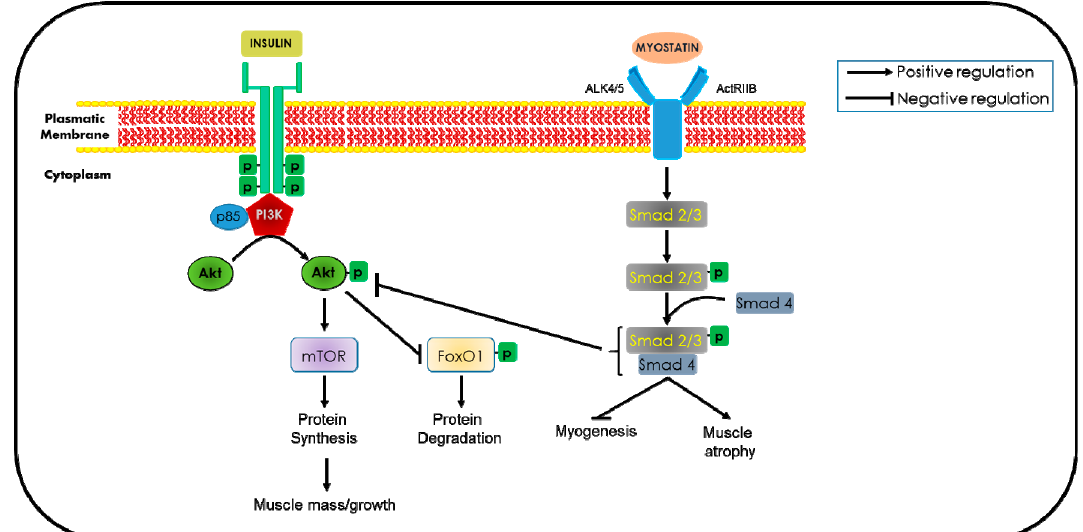
Figure 1. Schematic illustration of myostatin signaling pathway in sarcopenia. Signaling activated by insulin positively regulates muscle mass, downstream of protein kinase Akt and mTOR. Myostatin first binds to the activin receptor (ActRIIB)/Alk 4/5 on skeletal muscle causing phosphorylation of Smad2 and Smad3, and the recruitment of Smad4 into a Smad complex, which leads to muscle atrophy. Second, Smad 2/3/4 complex down-regulate the activity of Akt, thereby inhibiting protein synthesis. Akt blocks FOXO1 nuclear translocation to inhibit protein degradation.